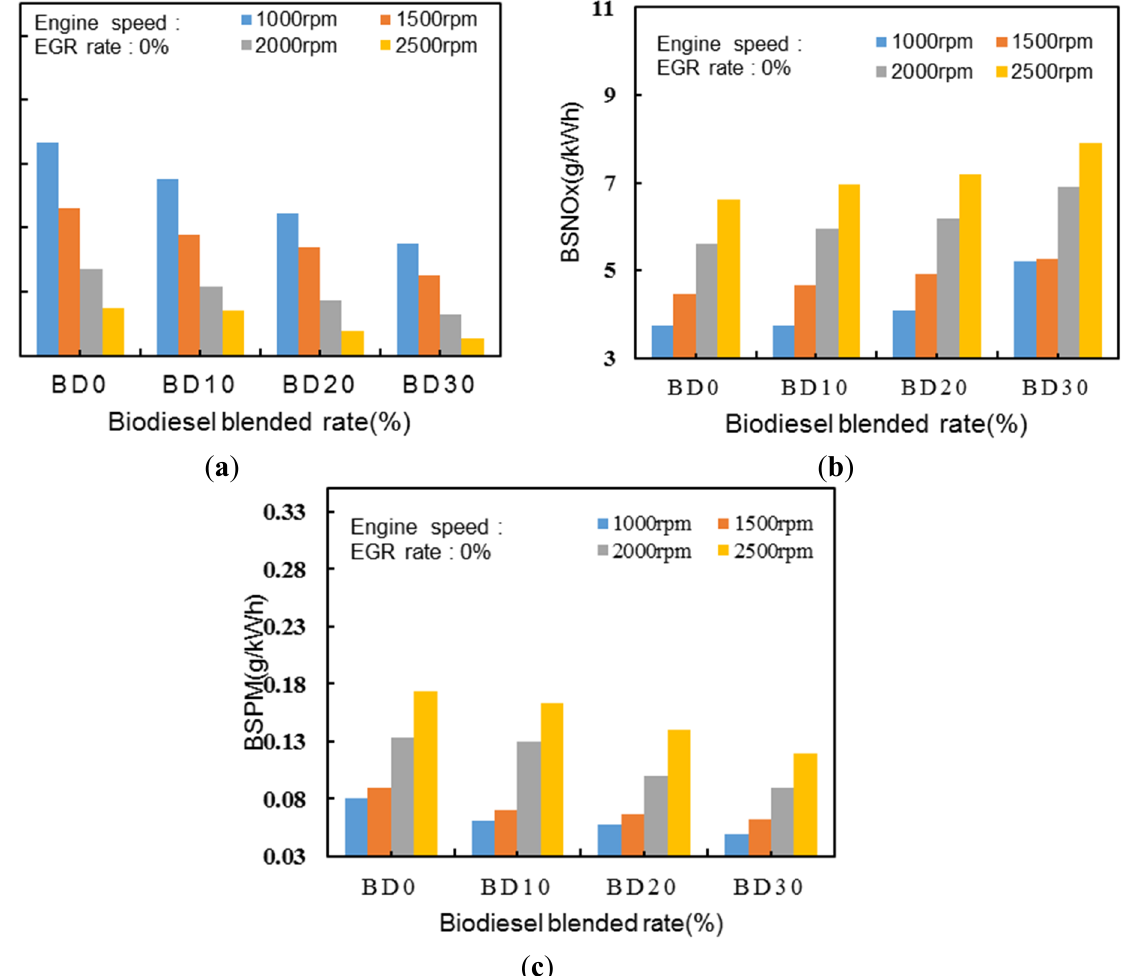
Figure 6. Effects of the engine speed and biodiesel blend ratio on the ( a ) brake specific carbon monoxide (BSCO); ( b ) brake specific nitrogen oxide (BSNO x ); and ( c ) brake specific particulate matter